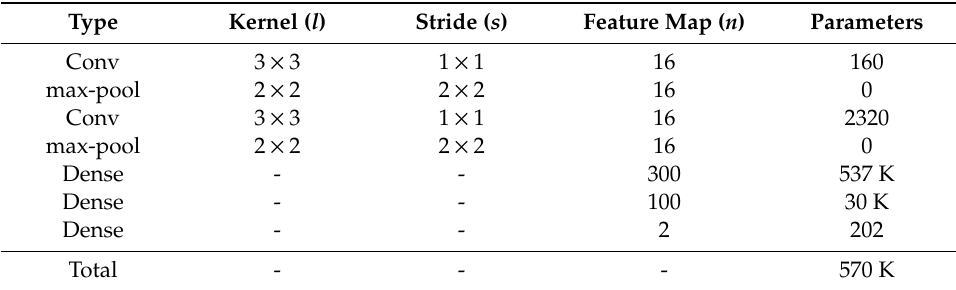
Table 5. Parameters used for the CNN system.